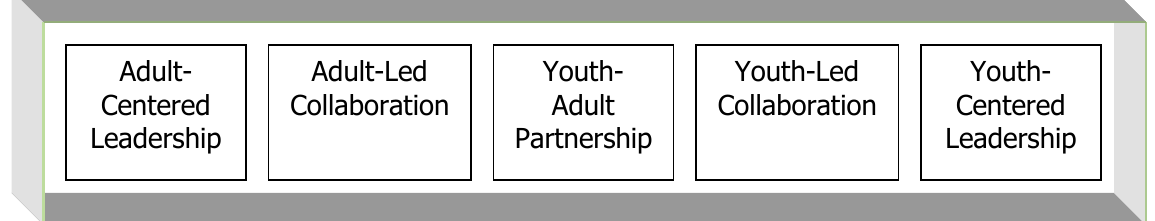
Figure 1. Youth-Adult Relationships